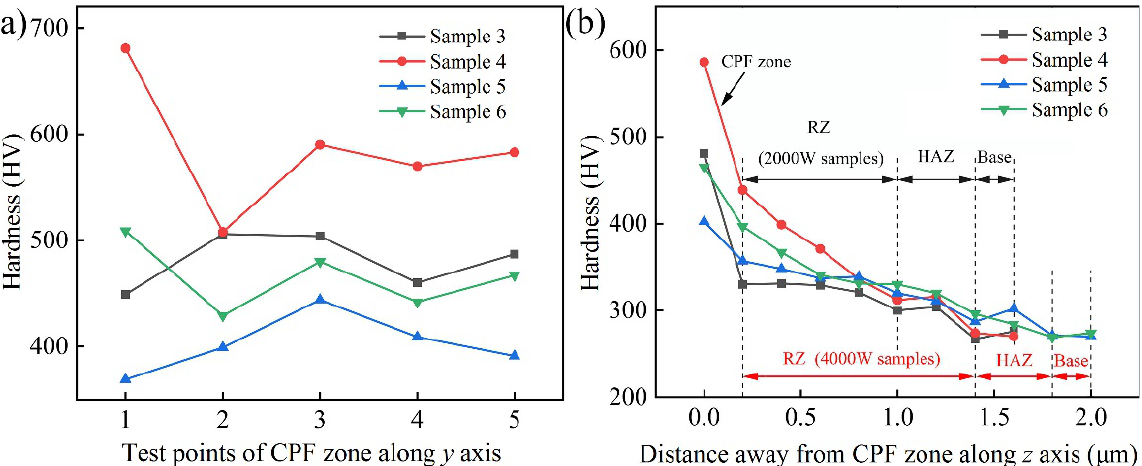
Figure 11. Hardness distribution of LSM-CPF process treatment samples: ( a ) CPF zone along y axis and ( b ) CPF zone to base material along z axis.